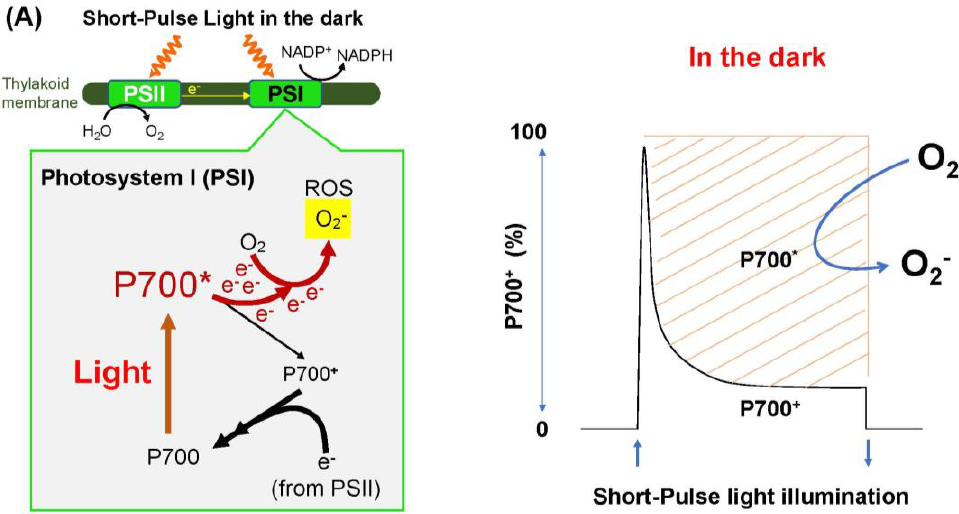
Figure 1. The photo-oxidation reduction cycle of P700 in Photosystem I (PSI). The reaction center chlorophyll P700 in PSI absorbs the light energy, and the P700 is excited to P700*. The P700* donates electrons to the electron carrier, A 0 , and concomitantly produces the oxidized P700, P700 + . The P700 + is reduced by electrons from Photosystem II (PSII) through plastoquinone (PQ), the cytochrome (Cyt) b6/f -complex, and plastocyanin (PC). The reduced PC directly donates electrons to P700. There are then P700 turnovers in the photo-oxidation reduction cycle of P700 in PSI. The electron on A 0 flows to NADP + to produce NADPH through the electron carriers A 1 , F x , F A /F B , and Fd. In the photosynthetic linear electron flow, electrons extracted from H 2 O oxidation in PSII flow to NADP + for the production of NADPH.